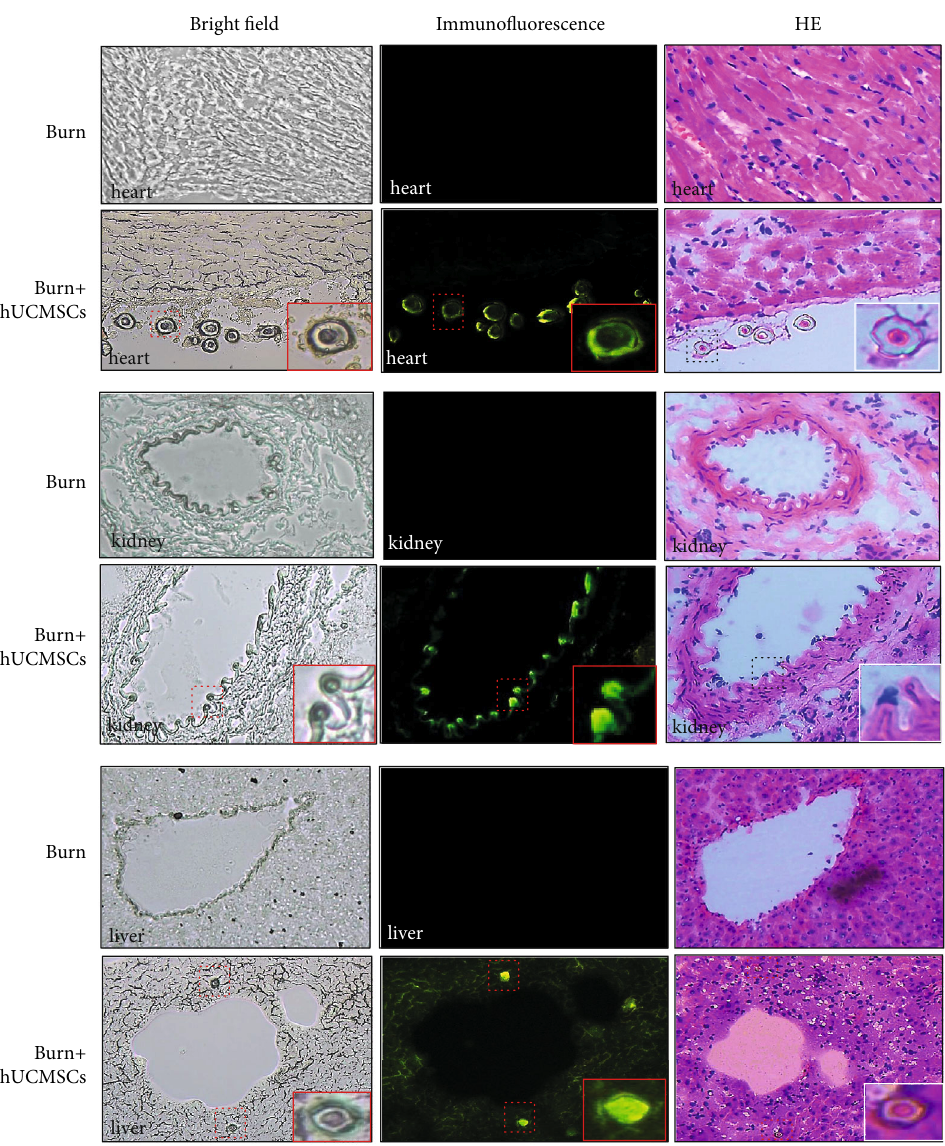
Figure 2: GFP-hUCMSCs were tracked in severely burned rats in vivo . The GFP-labeled hUCMSCs mainly migrated and distributed in blood vessels of the heart, kidney, and liver, and a very few cells migrated into tissues of these